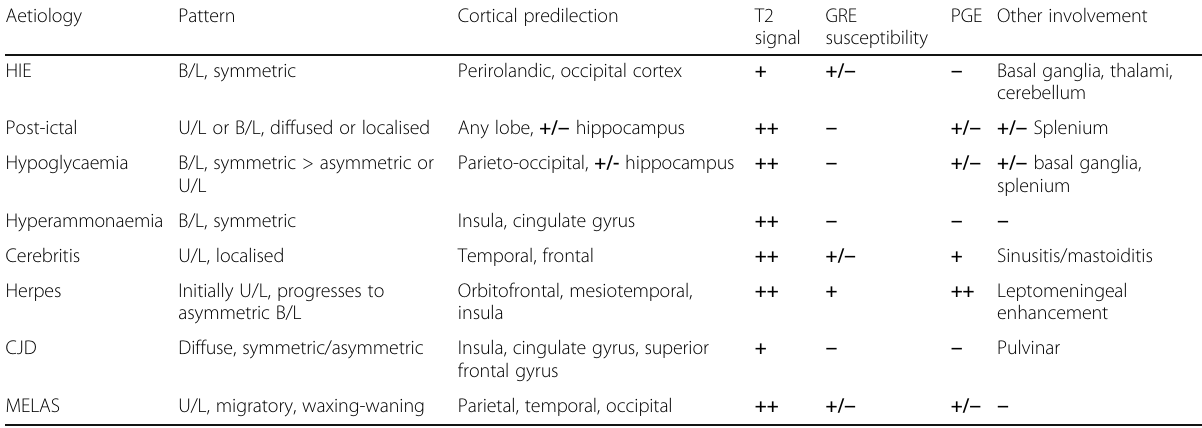
Table 1 Pattern-based approach to